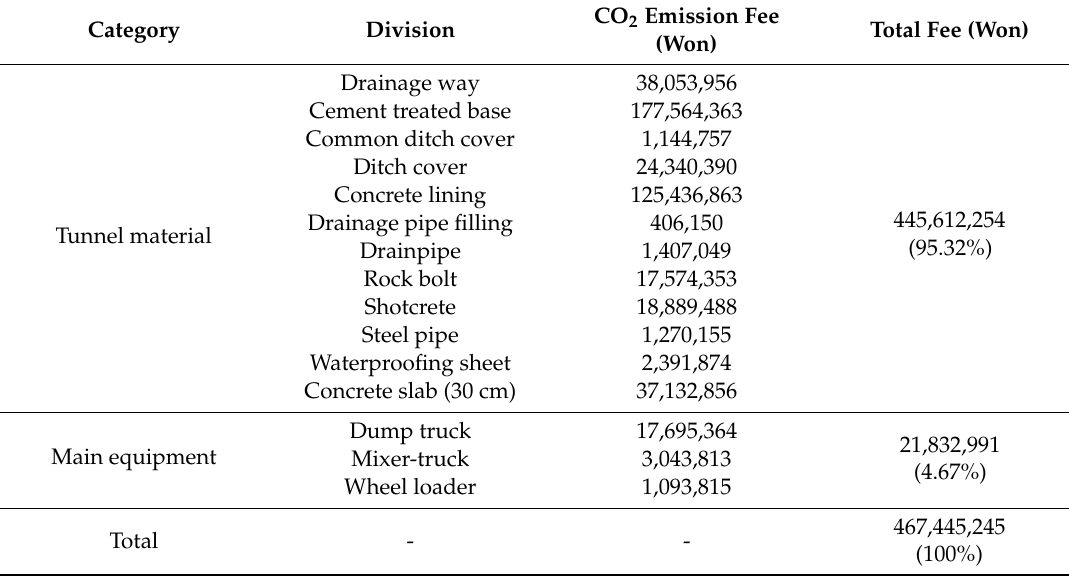
Table 9. Proportion of CO 2 emission fee during the construction process of project